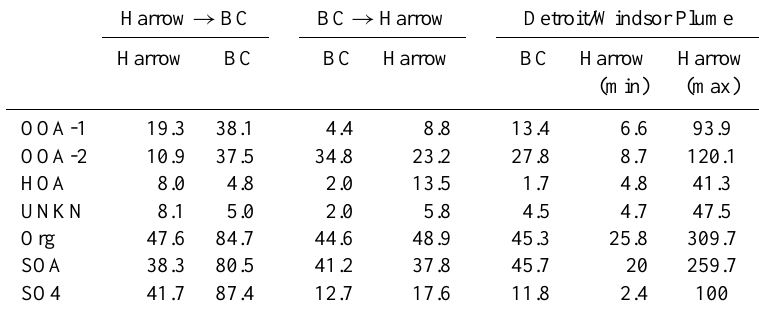
Table 1. Ratio of species concentration (µgm − 3 ) to CO (ppmv), with a CO background of 0.08ppmv subtracted. SOA is estimated as OOA-1+OOA-2+UNKN.